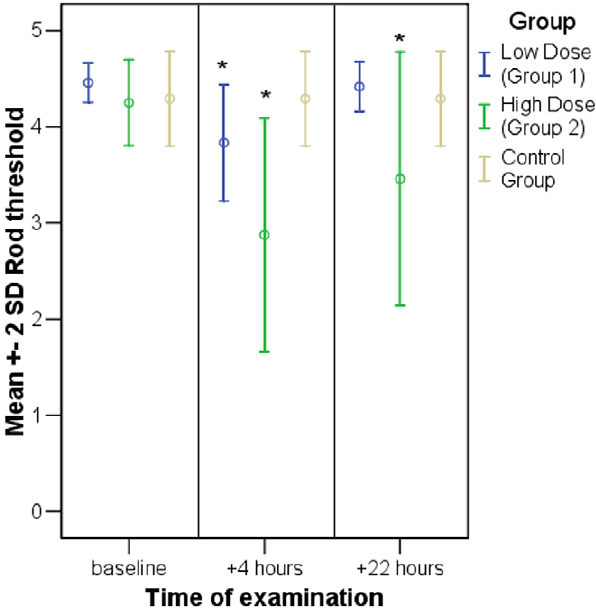
Figure 2. Lanthony Panel D-15 test of color vision. Time course of error score + / 2 2 * standard deviation. Mean values for 6 subjects of each group. A significant deterioration compared to baseline was observed in both treated groups immediately after treatment (asterisked bars). Table 4). In the dark-adapted ERG elicited by higher stimulus intensities the b- and a-waves were reduced in amplitude, reaching a significant only in group 1. The b/a-ratio was slightly and unsignificantly elevated in both treated groups after four hours.